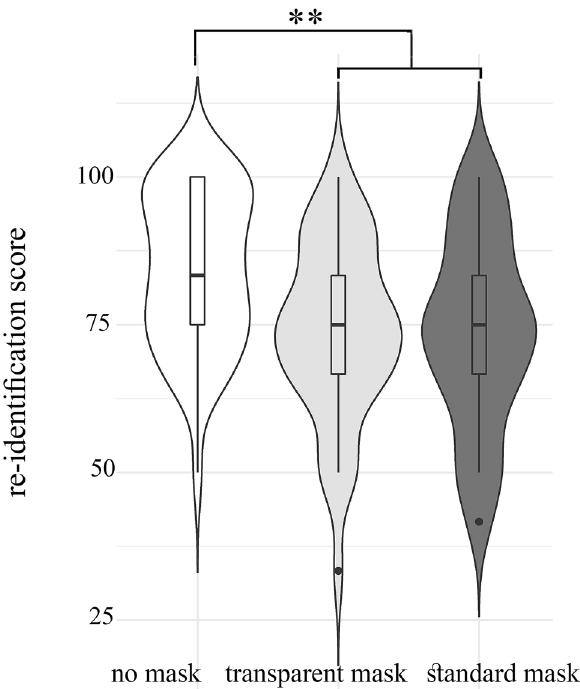
Figure 4. Re-identification task. The analysis of the correct re-identification of unmasked faces previously observed in masked (TM, SM) or unmasked (NM) fashion show a significant effect of Condition, indicating that the presence/type of mask affects the subsequent re-identification of that face, presented in an unmasked fashion. Boxplots within each violin represent interquartile ranges (IQRs). Black horizontal lines indicate median and black points are outliers. All conventions as in Fig.